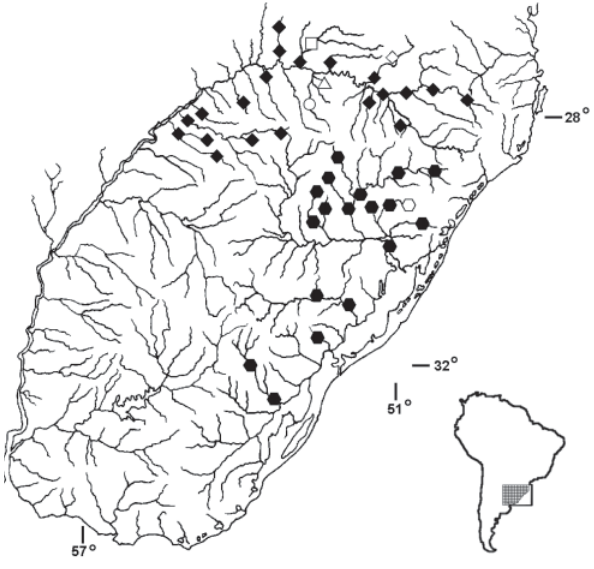
Fig. 5. Collection localities of H . votouro (triangle), H. meizospilos (square), H . punctulatus (hexagons), H . chlorostictus (circle) and H . fuliginosus (lozenges) in Rio Gran- de do Sul, Brazil, and Uruguay. Some symbols represent more than one lot or locality. Open symbols represent type localities.